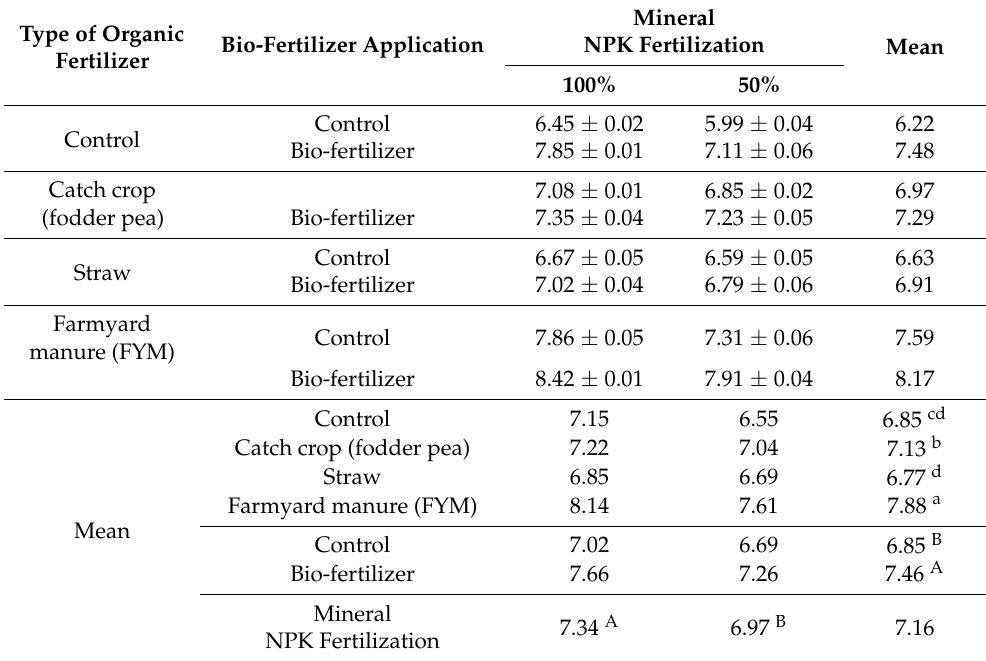
Table 10. Antioxidant capacity (FRAP) in potato tubers after 6 months of storage depending on the applied research factors (mmol Fe 2+ · kg − 1 ) (mean from 3